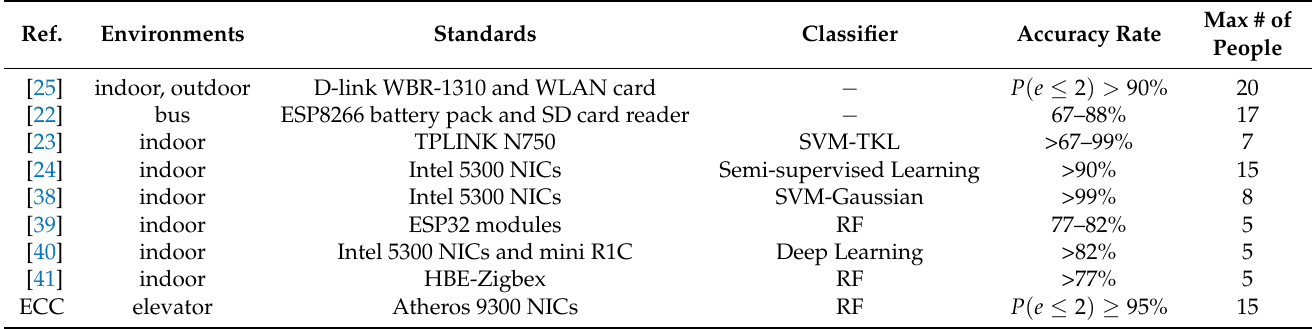
Table 1. Benchmark of indexes for state-of-the-art WiFi-based crowd counting.